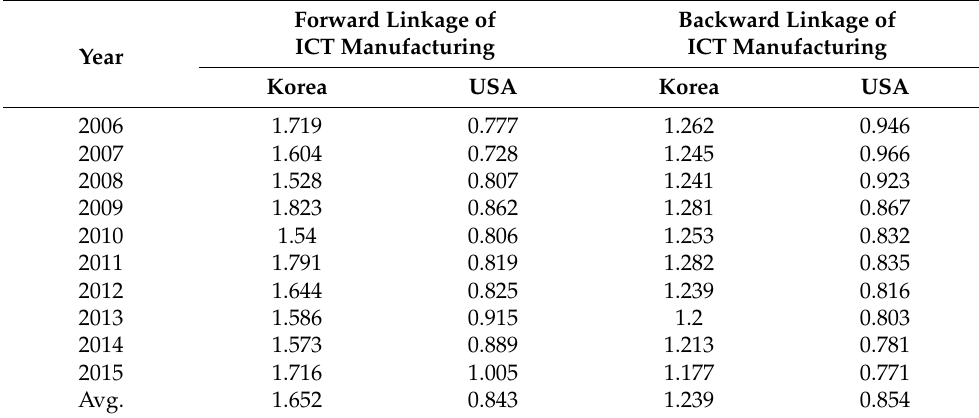
Table 8. Comparison of linkage effects of ICT manufacturing between Korea and USA.